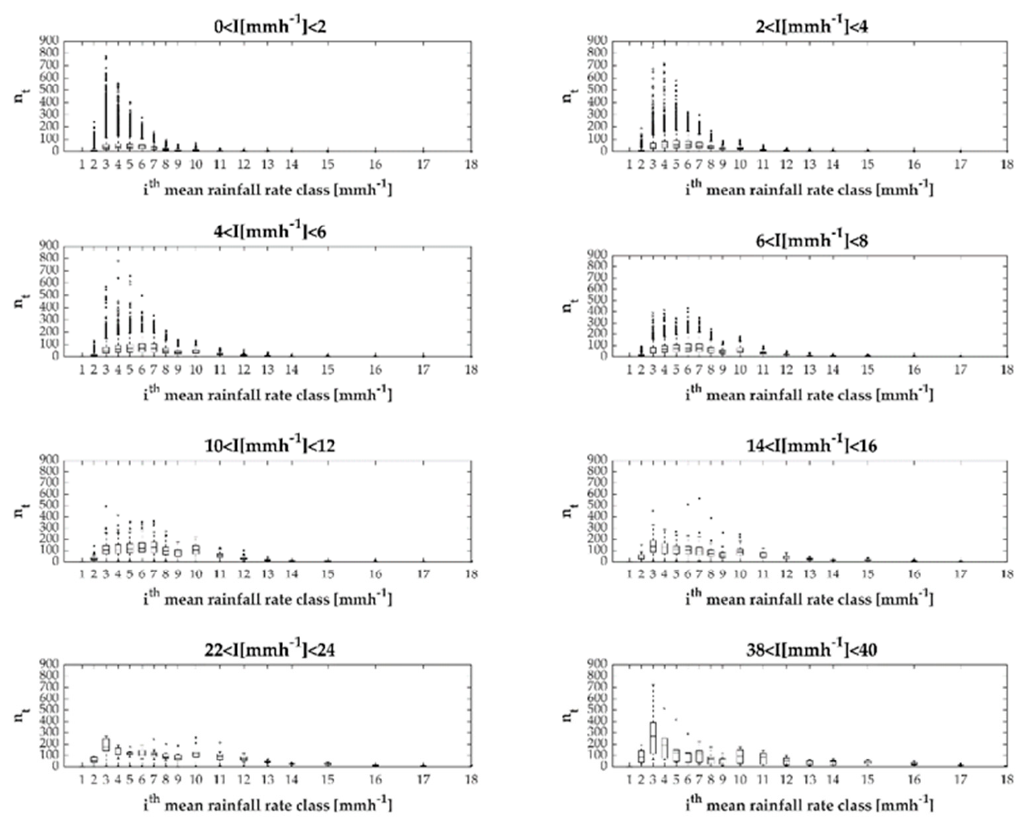
Figure 10. Number of drops falling in each class of diameters per each 1 min drop spectrum with increasing intensity.